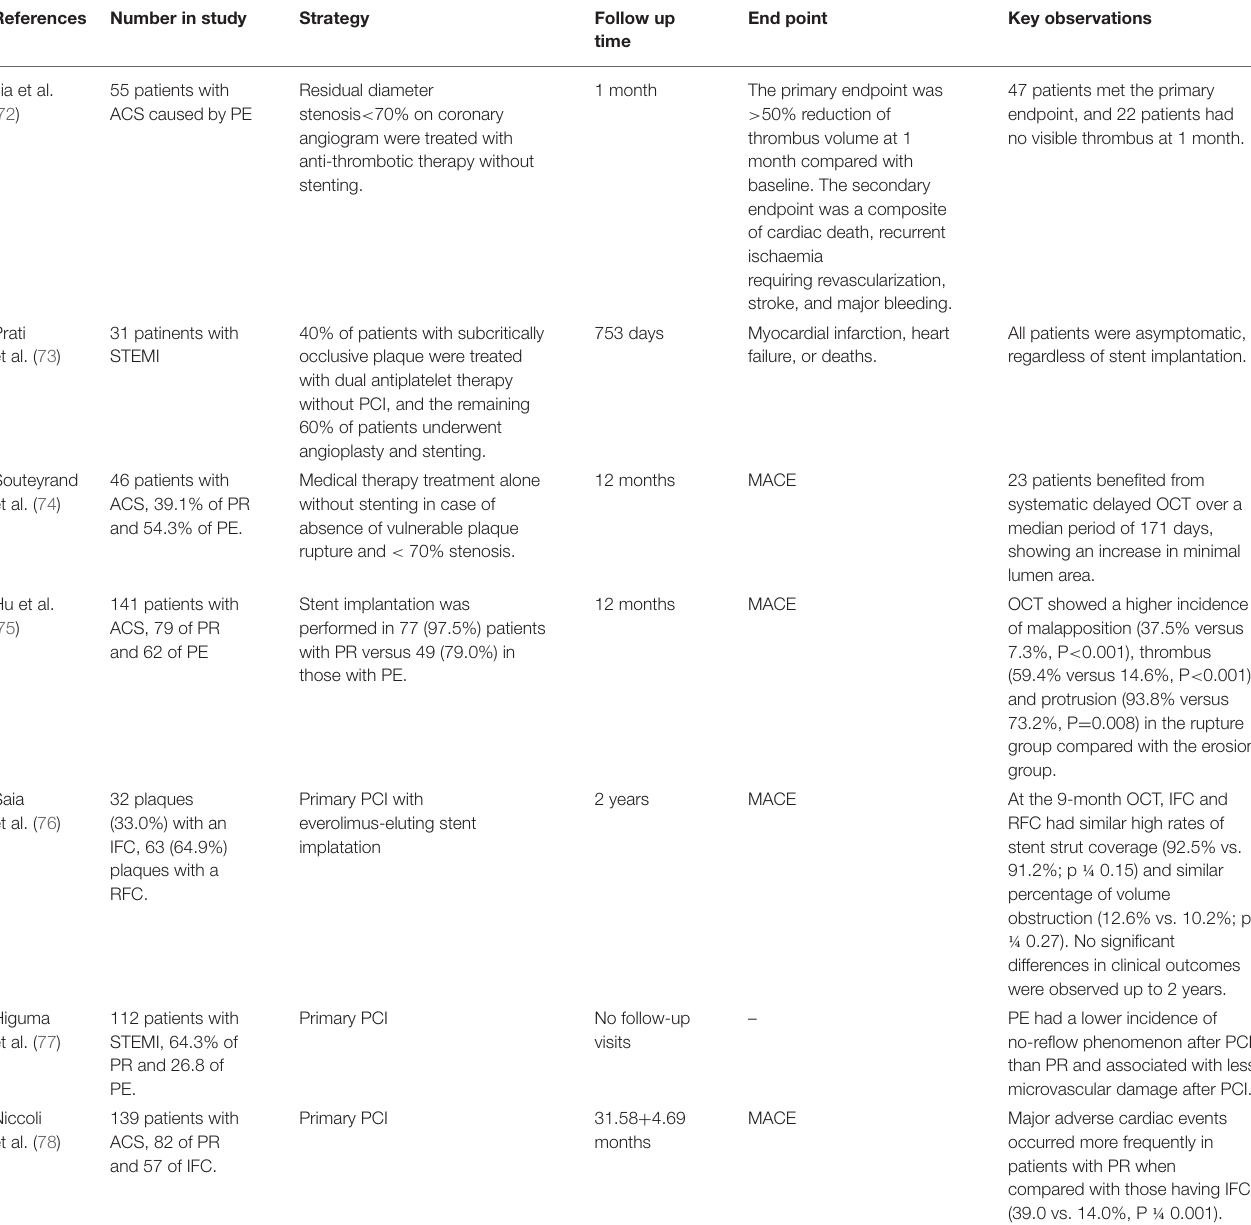
TABLE 1 | Representative studies of the clinical strategies and prognosis of the patients caused by plaque